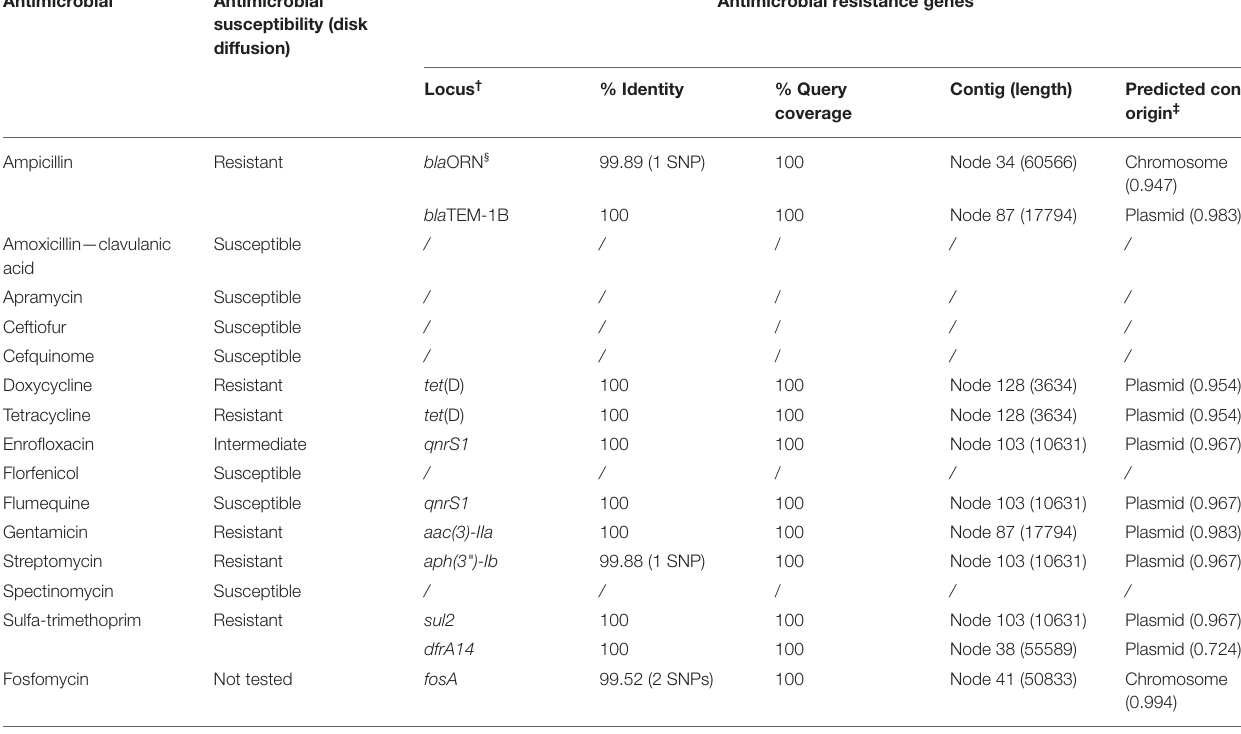
TABLE 1 | Antibiotic susceptibility and antimicrobial resistance genes of Raoultella ornithinolytica obtained from a calf with sepsis.